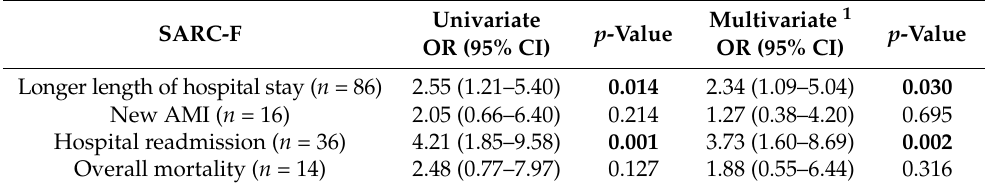
Table 3. Univariate and multivariate analyses of the association between the risk of sarcopenia and adverse outcomes in patients after an acute cardiovascular event ( n =